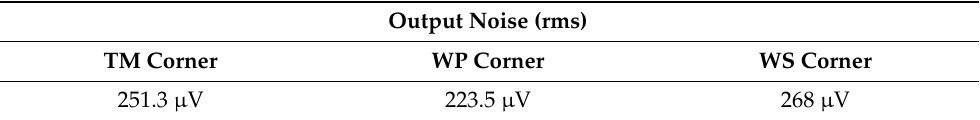
Table 16. Behavior of output noise in corner analysis.